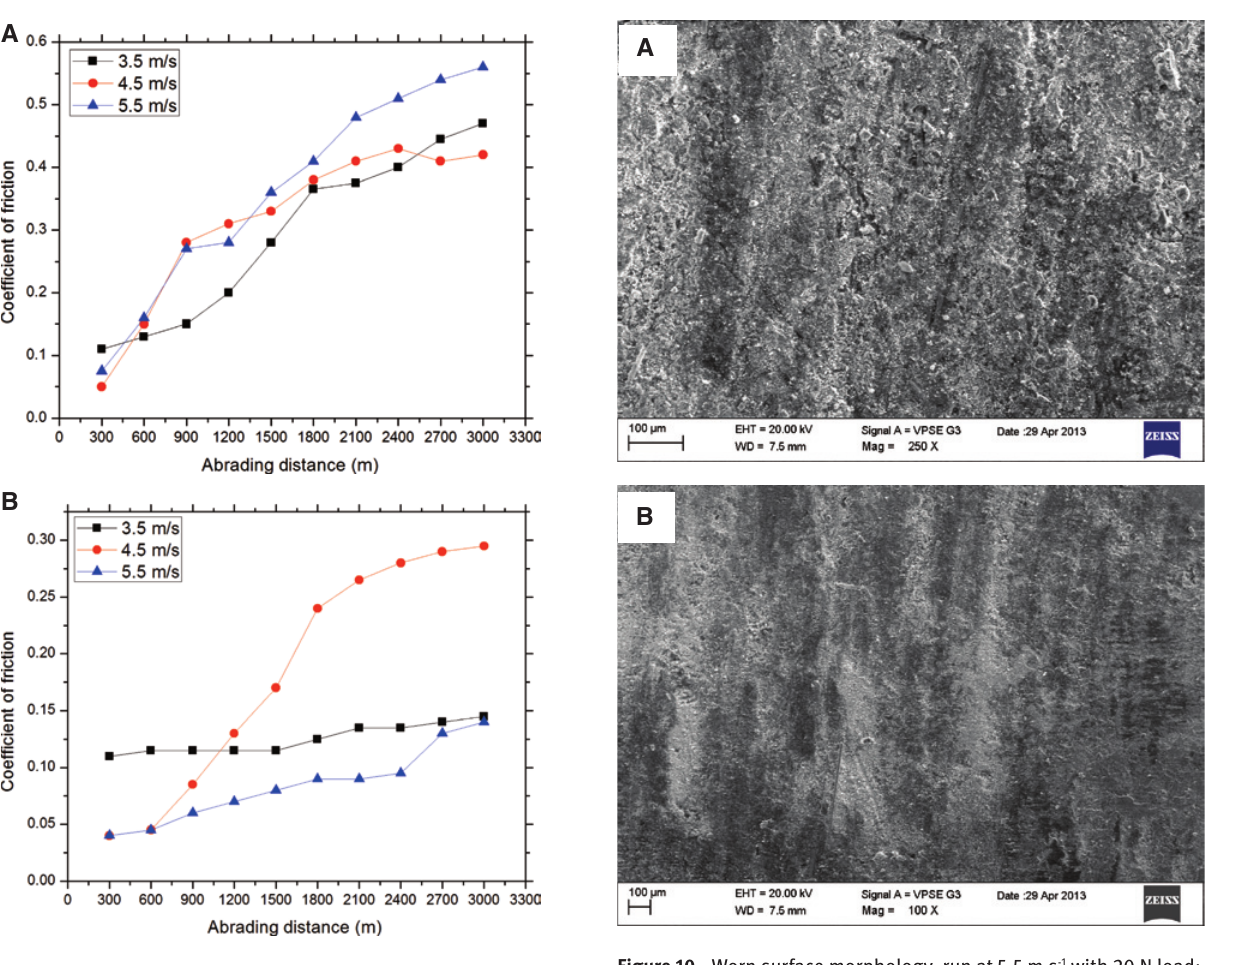
Figure 9 Effect of sliding velocity on coefficient of friction, run at 20 N load: untreated composites (A) and alkali-treated composites